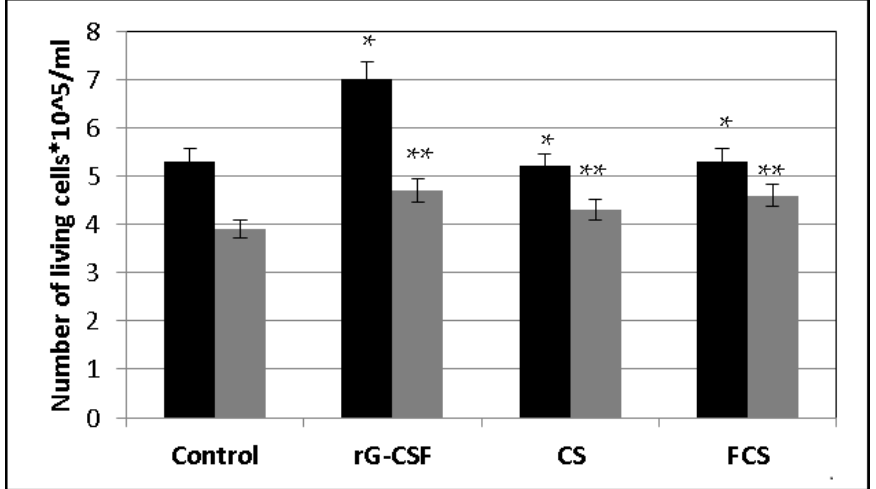
Figure 6. Number of bone marrow living cells after the treatment with recombinant granulocyte colony-stimulating factor (r G-CSF), chondroitin sulfate ( CS ) and fucosylated chondroitin sulfate ( FCS ) (mean ± SD). ■ Bone marrow cells, ■ bone marrow cells after cisplatin exposure. * p < 0.05 vs. control, ** p < 0.05 vs. Cis.